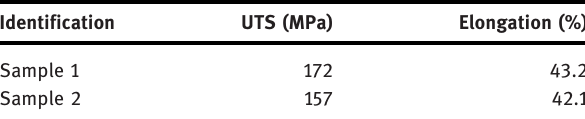
Table 2: Mechanical testing results of failed primary superheater